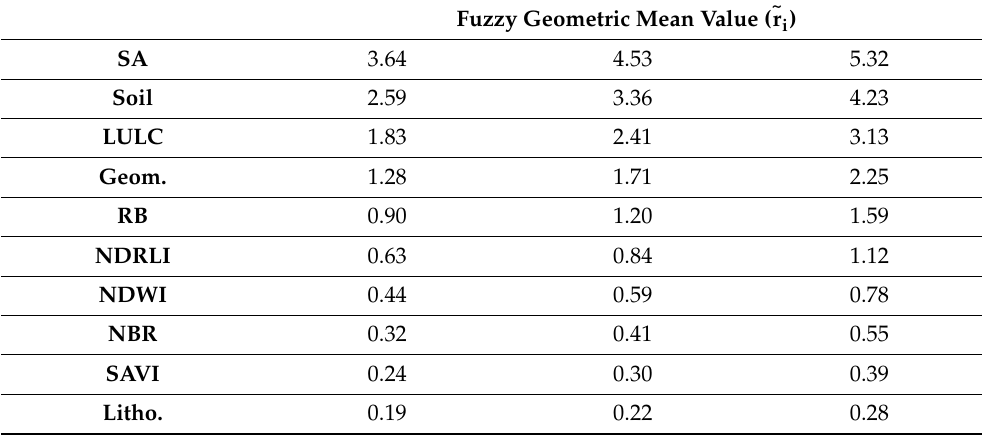
Table 5. Geometric means of fuzzy comparison values.